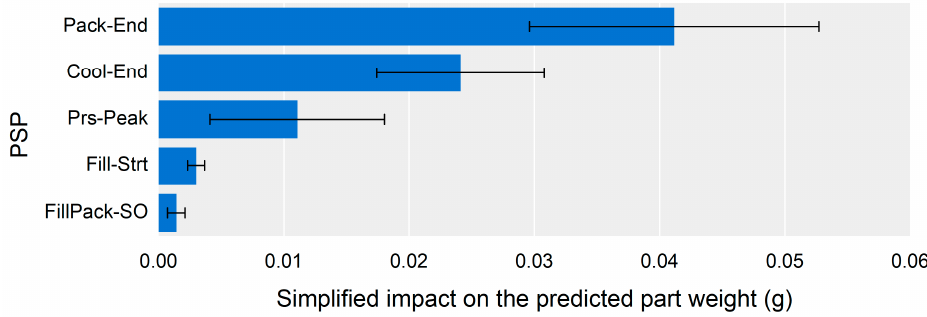
Figure 10. Simplified impact of the PSPs on the part weight.